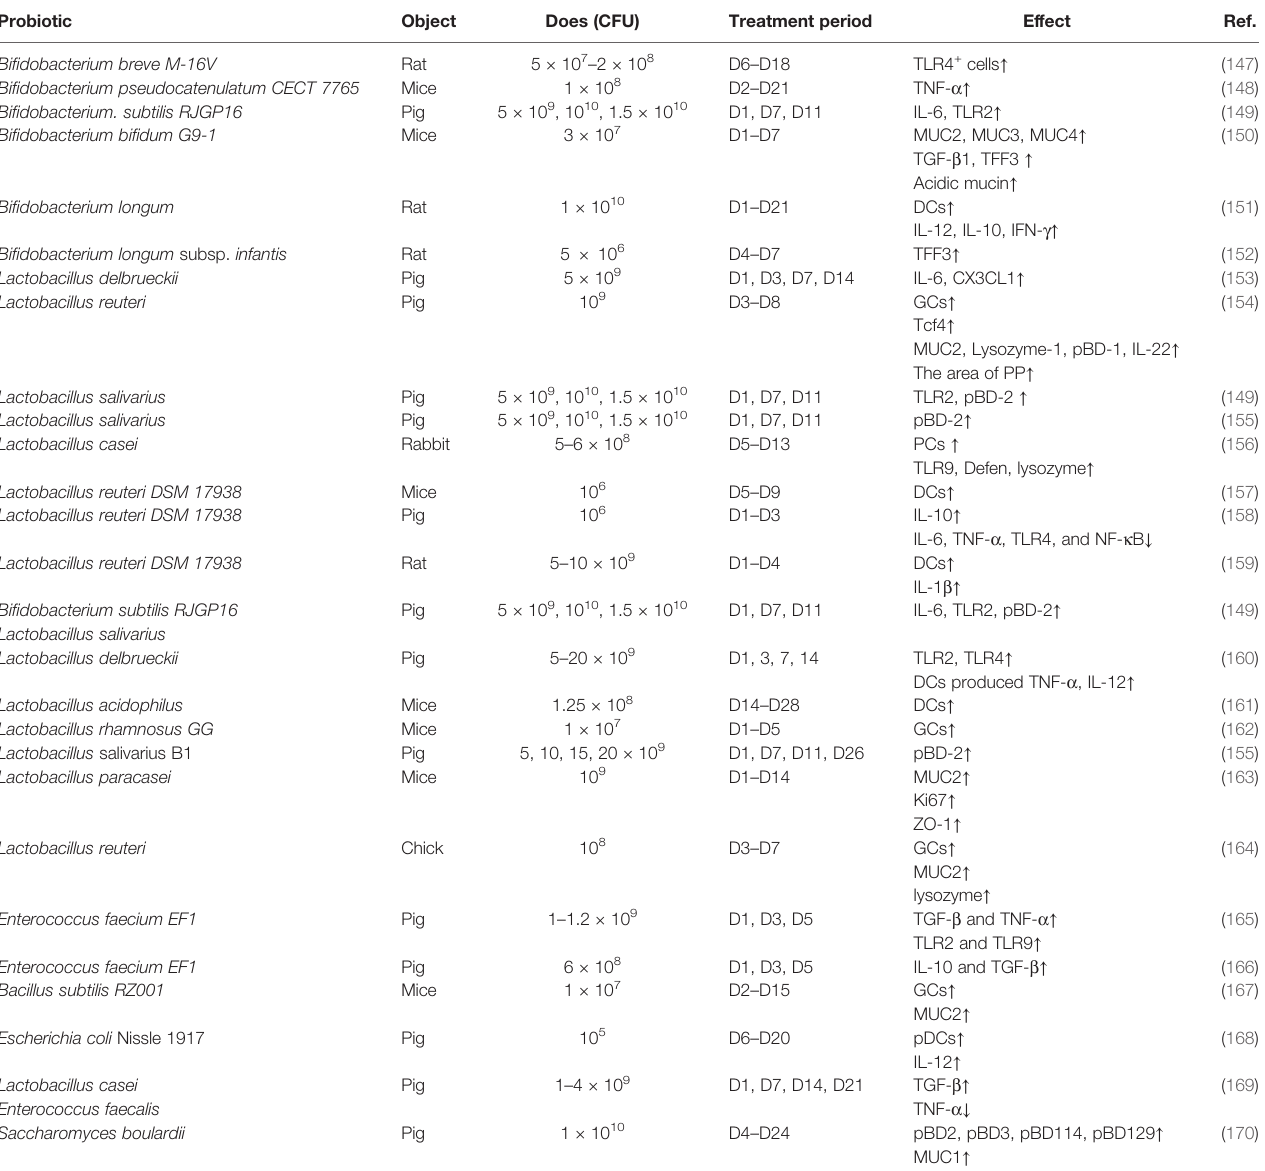
TABLE 1 | The effect of probiotics on the intestinal innate